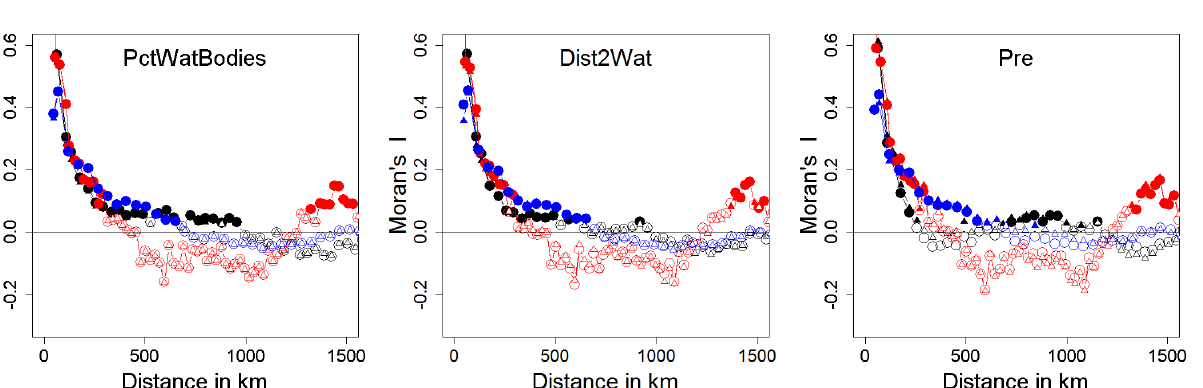
Figure A1. Moran’s I correlograms of the residuals obtained after fitting Generalized Linear Models (GLM) models to the relationship between EFT richness and different environmental variables using first (circles) and second (triangles) degree polynomials. Relationships were compared across a gradient of Human Influence Index (HII): Natural ecosystems (in black; HII < 10), mixed (in blue; 10 < HII < 20) and anthropogenic systems (in red; HII > 20). Significant Moran’s I values (p < 0.05; 100 resamples) are shown as solid symbols. (Same order as in Table